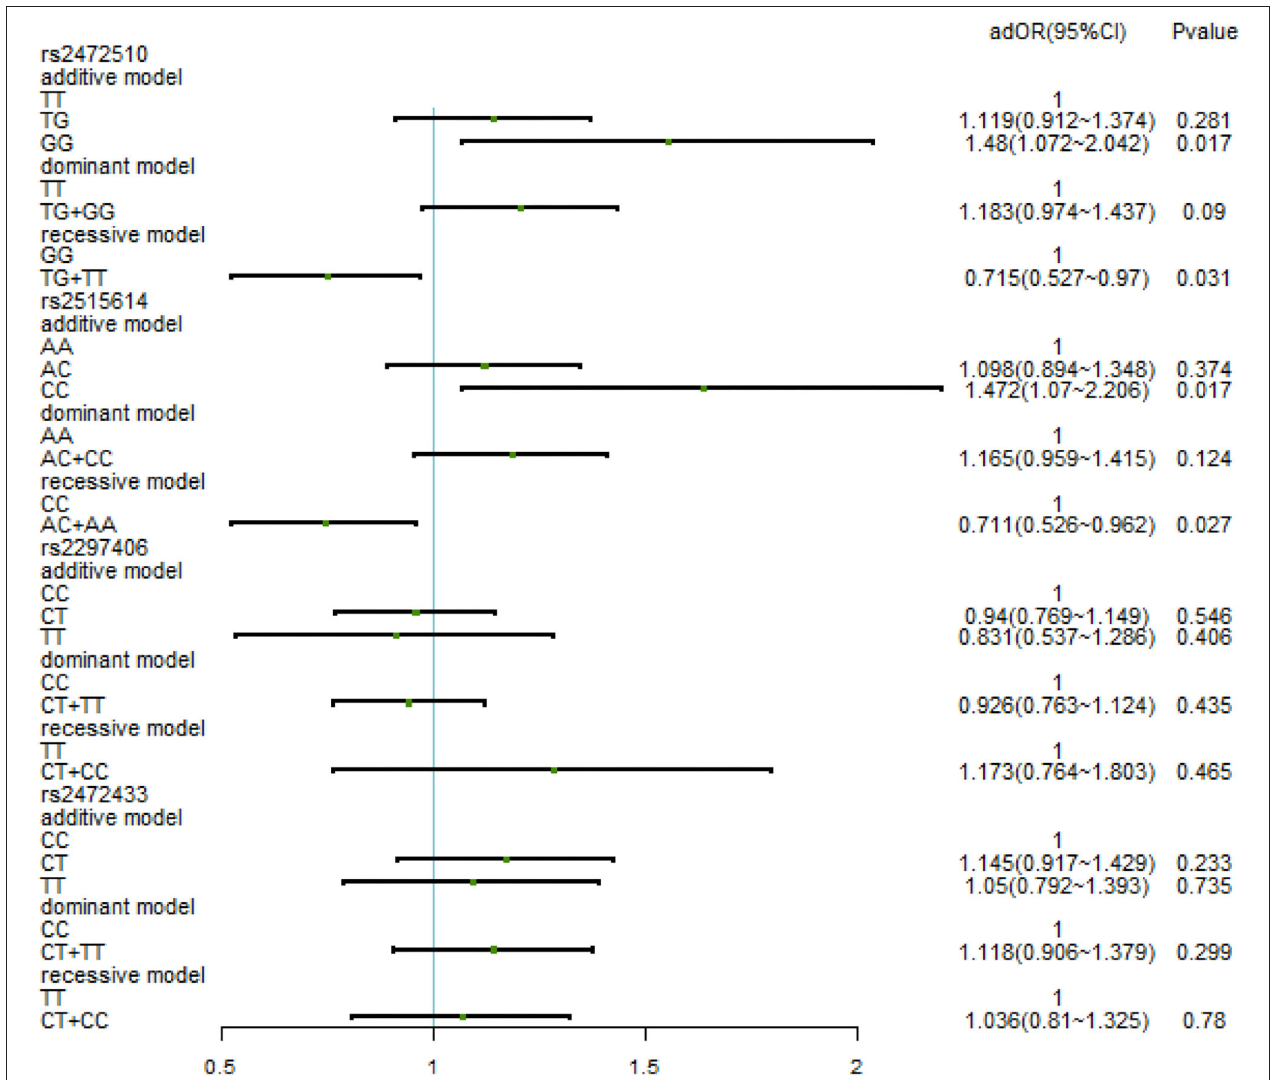
FIGURE 4 | Binary logistic regression analysis for association between genotypes of rs2472510, rs2515614, rs2297406, rs2472433, and high DBP. Adjusted some covariates, gender, age, BMI, waist circumference, TC/TG/LDL-C, family history of the disease, education level, times of fried foods per week, times of desserts per week, and daily iodized salt